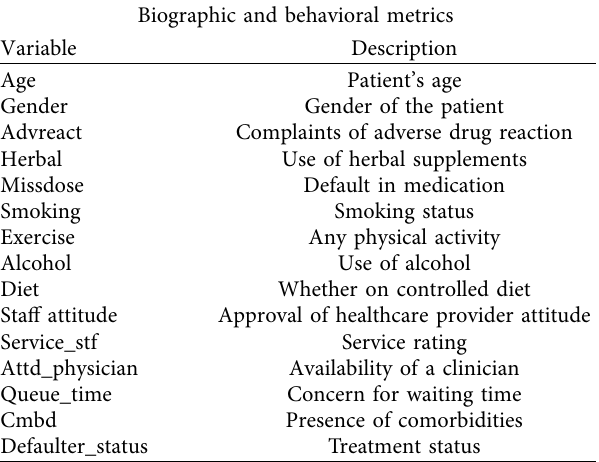
Table 3: Contextual biographic and behavioral variables. Biographic and behavioral